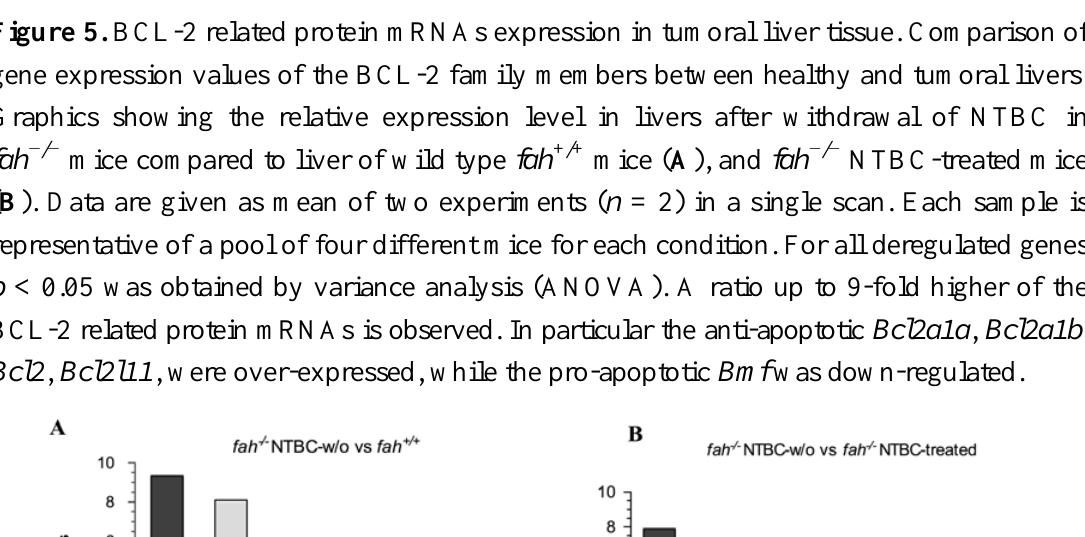
Figure 5. BCL-2 related protein mRNAs expression in tumoral liver tissue. Comparison of gene expression values of the BCL-2 family members between healthy and tumoral